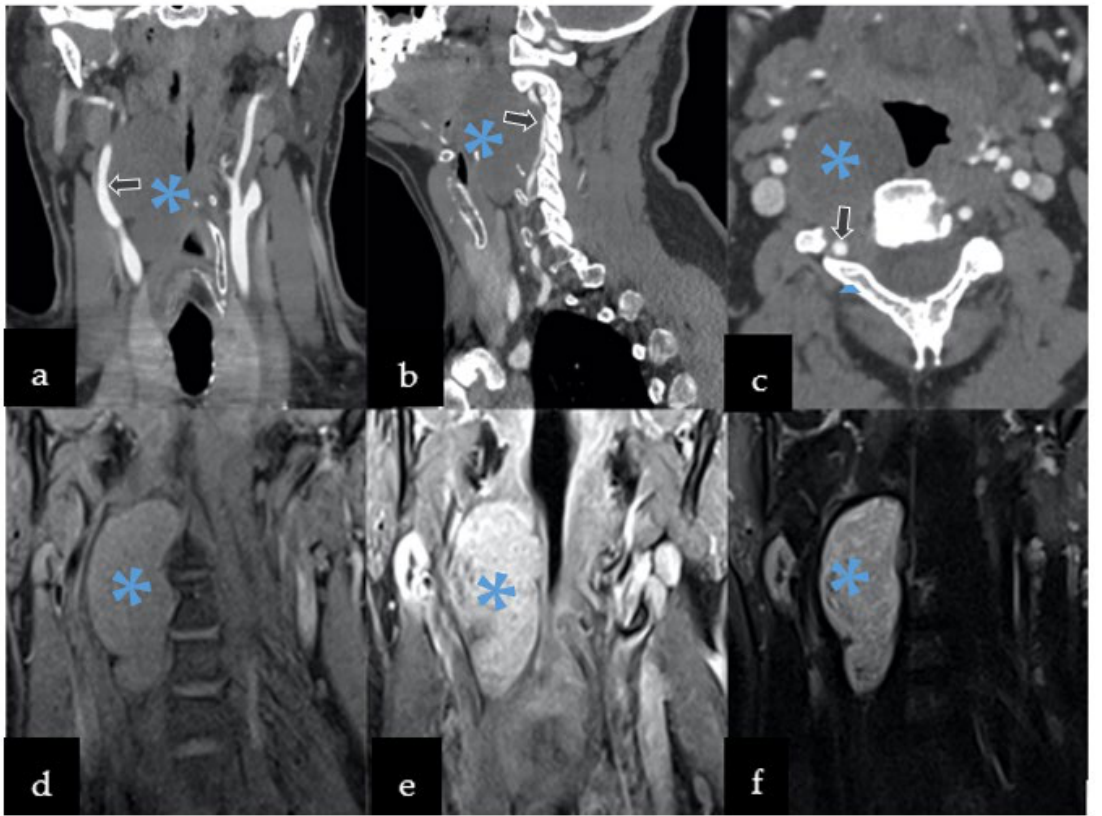
Figure 1. Preoperative imaging included both computed tomography angiography (CTA) and magnetic resonance imaging (MRI). CTA revealed hypodense well-defined mass with calcification displacing the vessels in the following planes: ( a ) coronal, ( b ) sagittal, and ( c ) axial. MRI was characterized by: ( d ) by low T1 signal, with ( e ) T1 contrast enhancement, and ( f ) heterogeneously hyperintense T2 signal. Legend: arrows—compression and displacement of the right carotid artery,